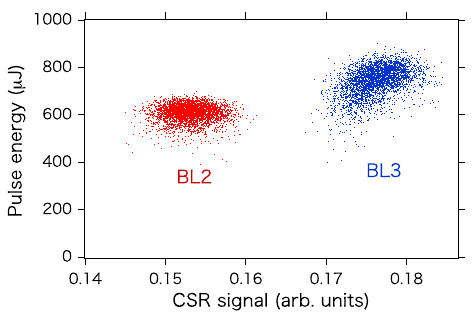
FIG. 9. XFEL pulse energies of BL2 and BL3 measured as a function of the CSR signal at BC3. The red and blue dots represent the pulses of BL2 and BL3, respectively.